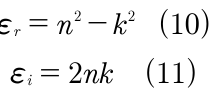
Figure 2: SEM Image of the CoS thin films